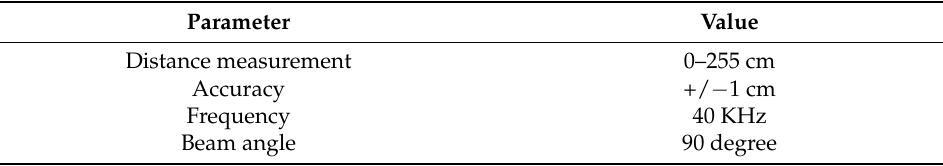
Figure 7. Experiment testbed area. Table 1. General specification parameters for the ultrasonic sensor. Table 5. Several parameters for the experiment.